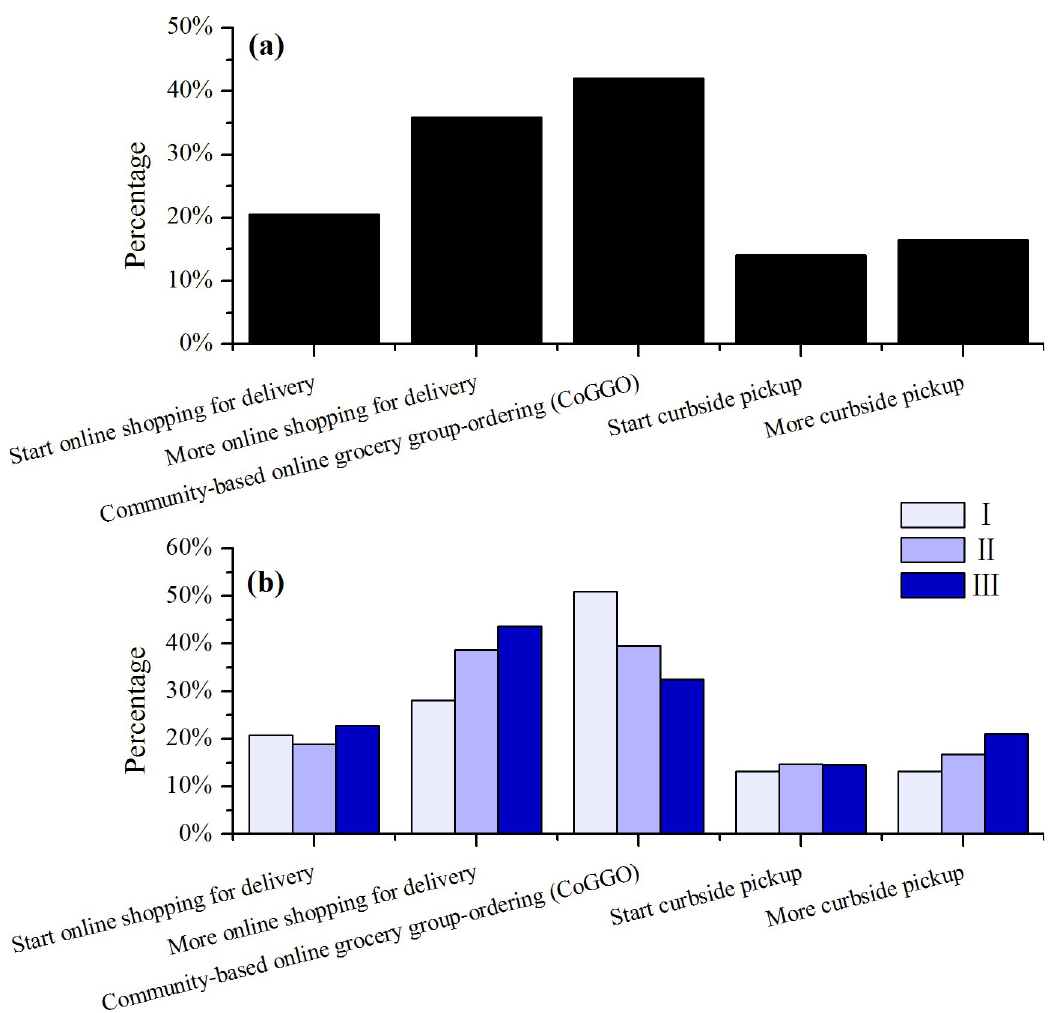
Fig 1. Household food sourcing change during the pandemic compared with before of the whole respondents (a) and different age group (b, p < 0.001).